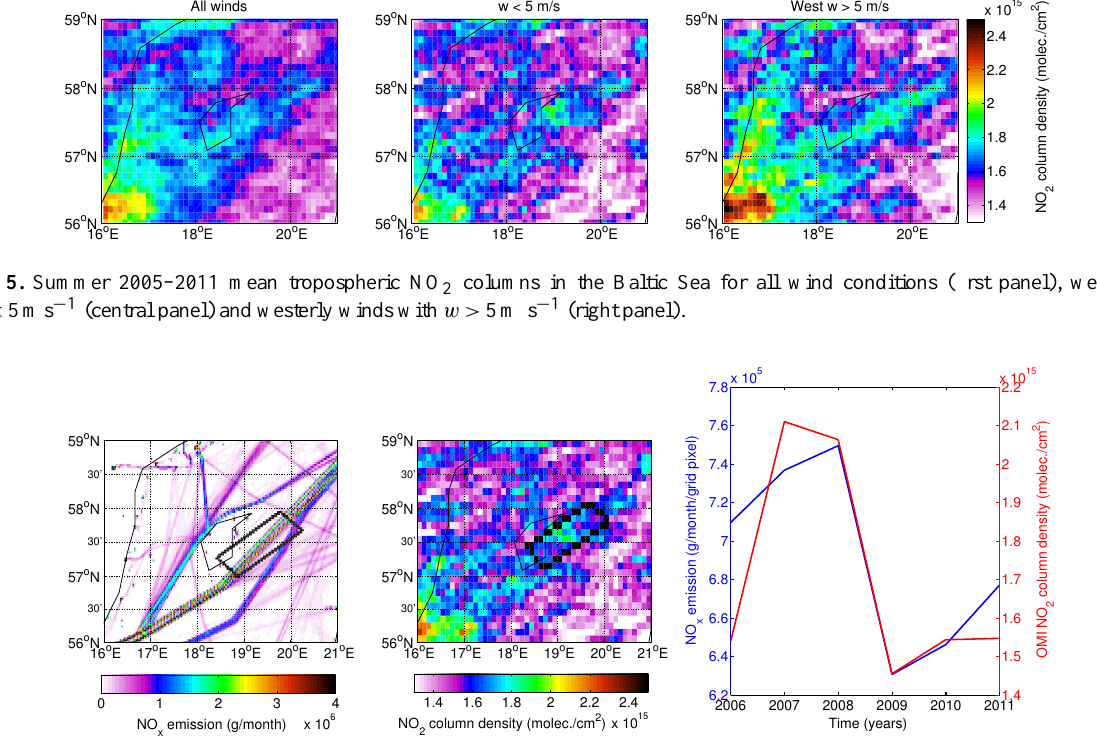
Figure 6. Comparison between STEAM NO x emissions and OMI NO 2 tropospheric columns during the period 2006–2011. Left panel: July–August cumulative NO x emissions from STEAM; central panel: July–August mean NO 2 tropospheric columns from OMI; right panel: time series of both NO x emissions (blue line) and NO 2 columns (red line) as derived from the mean value within the black boxes in the left and central panel, respectively. Note that the axes have been selected so that the observed decreases have the same size in the